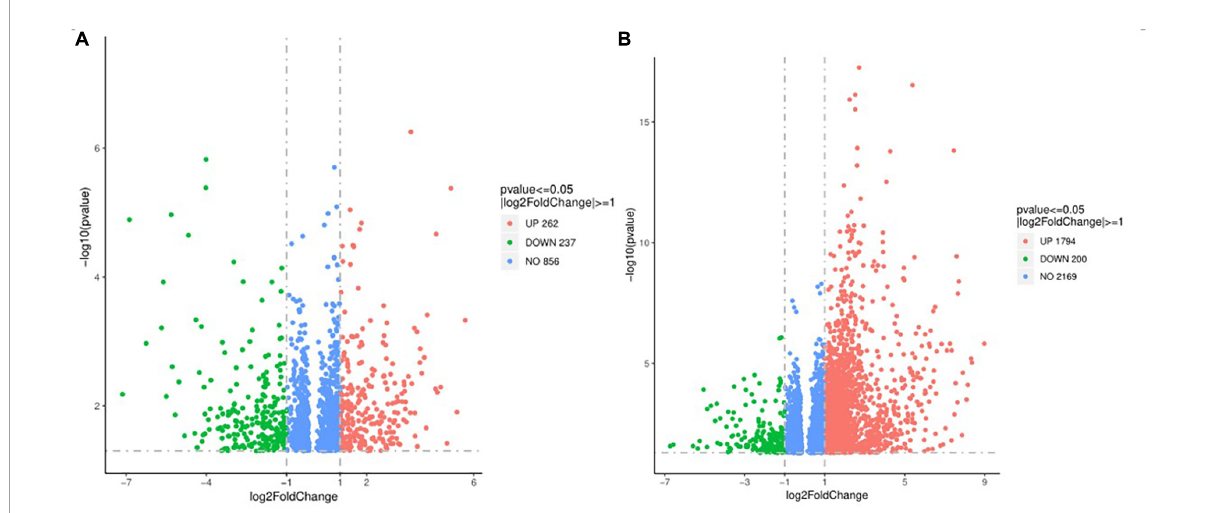
FIGURE5 Volcano plot of DEG in each group. (A) Volcano plot of DEG between model group and sham group. (B) Volcano plot of DEG between model group and EA group. In the figure, the X -axis is log2FoldChange, and the Y -axis is -log10 ( p -value). The gray dotted line is the threshold line representing the screening criteria of DEG. Red represents the up-regulated DEG, green represents the down-regulated